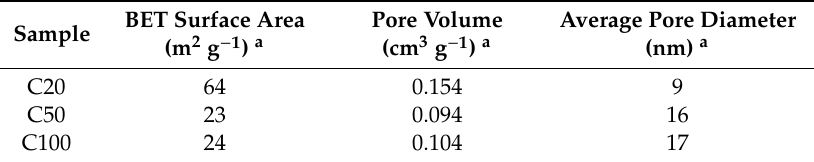
Table 1. The physical properties for CeO 2